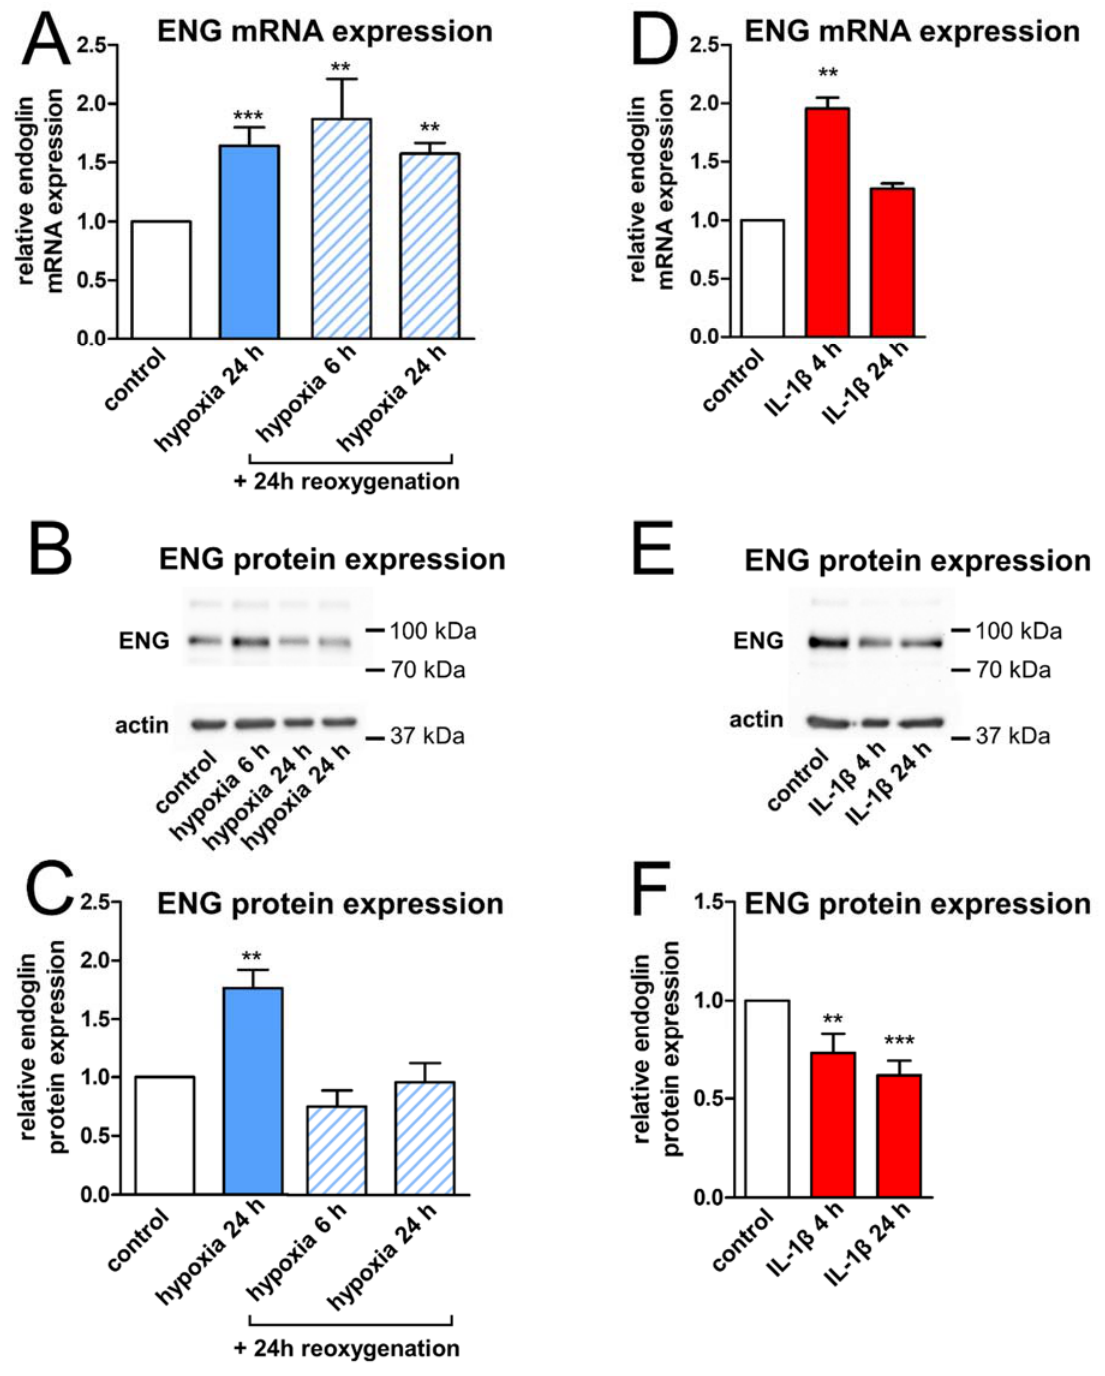
Figure 1. Hypoxia ‐ and inflammation ‐ modulated endoglin (ENG) expression in human brain endothelial cells (HBMEC). ( A ) ENG mRNA levels by quantitative real ‐ time PCR in HBMEC after hypoxia (1% O 2 ) or hypoxia/reoxygenation for the indicated durations relative to an unstimulated control. Data of six independent experiments and statistical analysis by the Kruskal – Wallis test followed by Dunn’s post ‐ hoc test. ( B ) Representative Western blot on whole ‐ cell extracts after stimulation as in A. ( C ) Quantification of ENG protein expression relative to β‐ actin in stimulated compared to unstimulated HBMEC of four independent experiments. Statistical testing for normal distribution by the D’Agostino – Pearson omnibus K2 test, followed by one ‐ way ANOVA and the Bonferroni post ‐ hoc test. ( D–F ) ENG mRNA levels and ENG protein concentrations after stimulation with IL ‐ 1 β (10 ng/mL) for 4 h and 24 h. Statistics as in B. Asterisks indicate significance compared to an unstimulated control (** p < 0.01; *** p < 0.001).